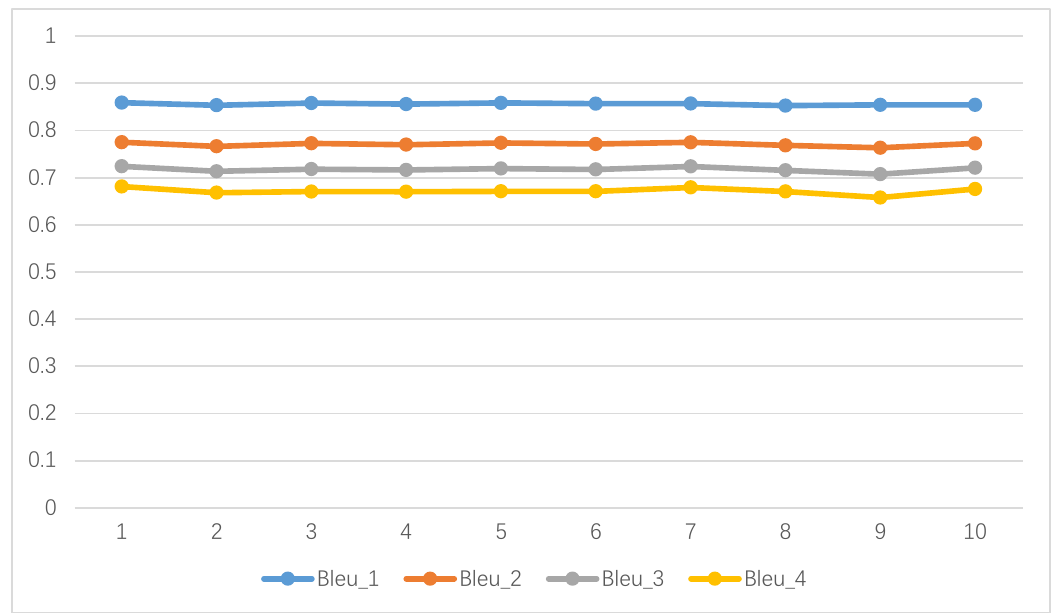
Figure 10. Bleu trend of the 10 experiments. It can be seen from the figure that in these experiments, the variation amplitudes of Bleu_1, Bleu_2, Bleu_3 and Bleu_4 are subtle, which can prove the randomness of the data distribution and the robustness of the algorithm.